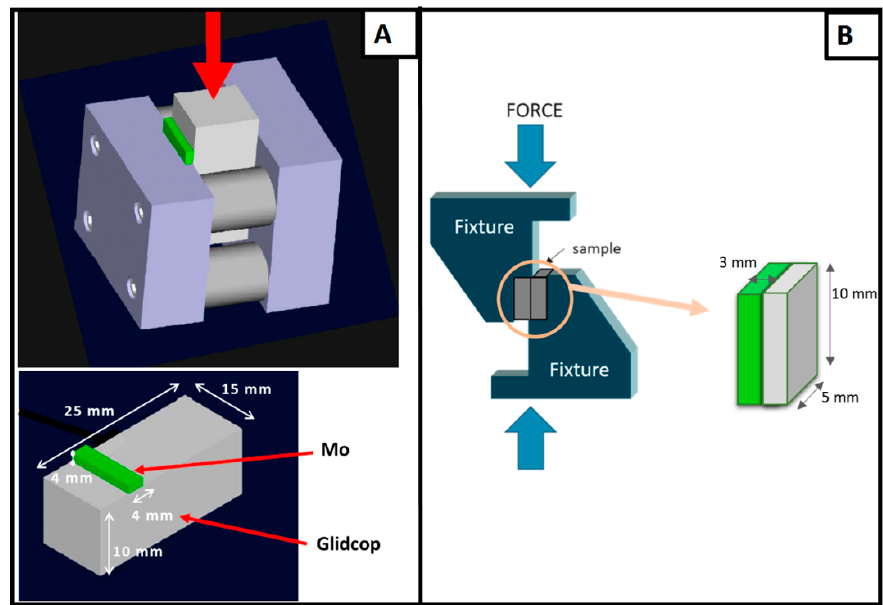
Figure 1. Configuration for measuring the apparent shear strength of Mo/Glidcop joined samples: ( A ) ASTM B898-11 standard (Glidcop size of 25 × 15 × 10 mm and Mo size 4 × 15 × 4 mm) and ( B ) single-lap test, adapted from ASTM D905-08 (adherends size: 5 × 10 × 3 mm).